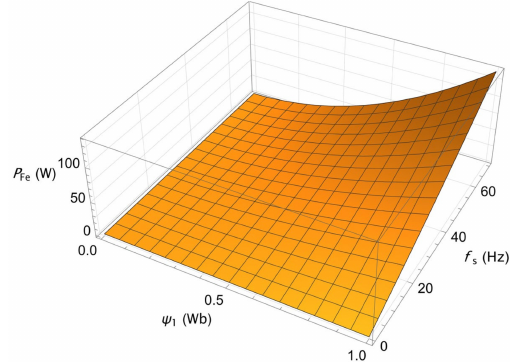
Figure 3. Iron losses as a function of fundamental supply frequency and stator flux linkage vector amplitude. The fitted model parameters are R Fe0 = 277, κ = 460, n =